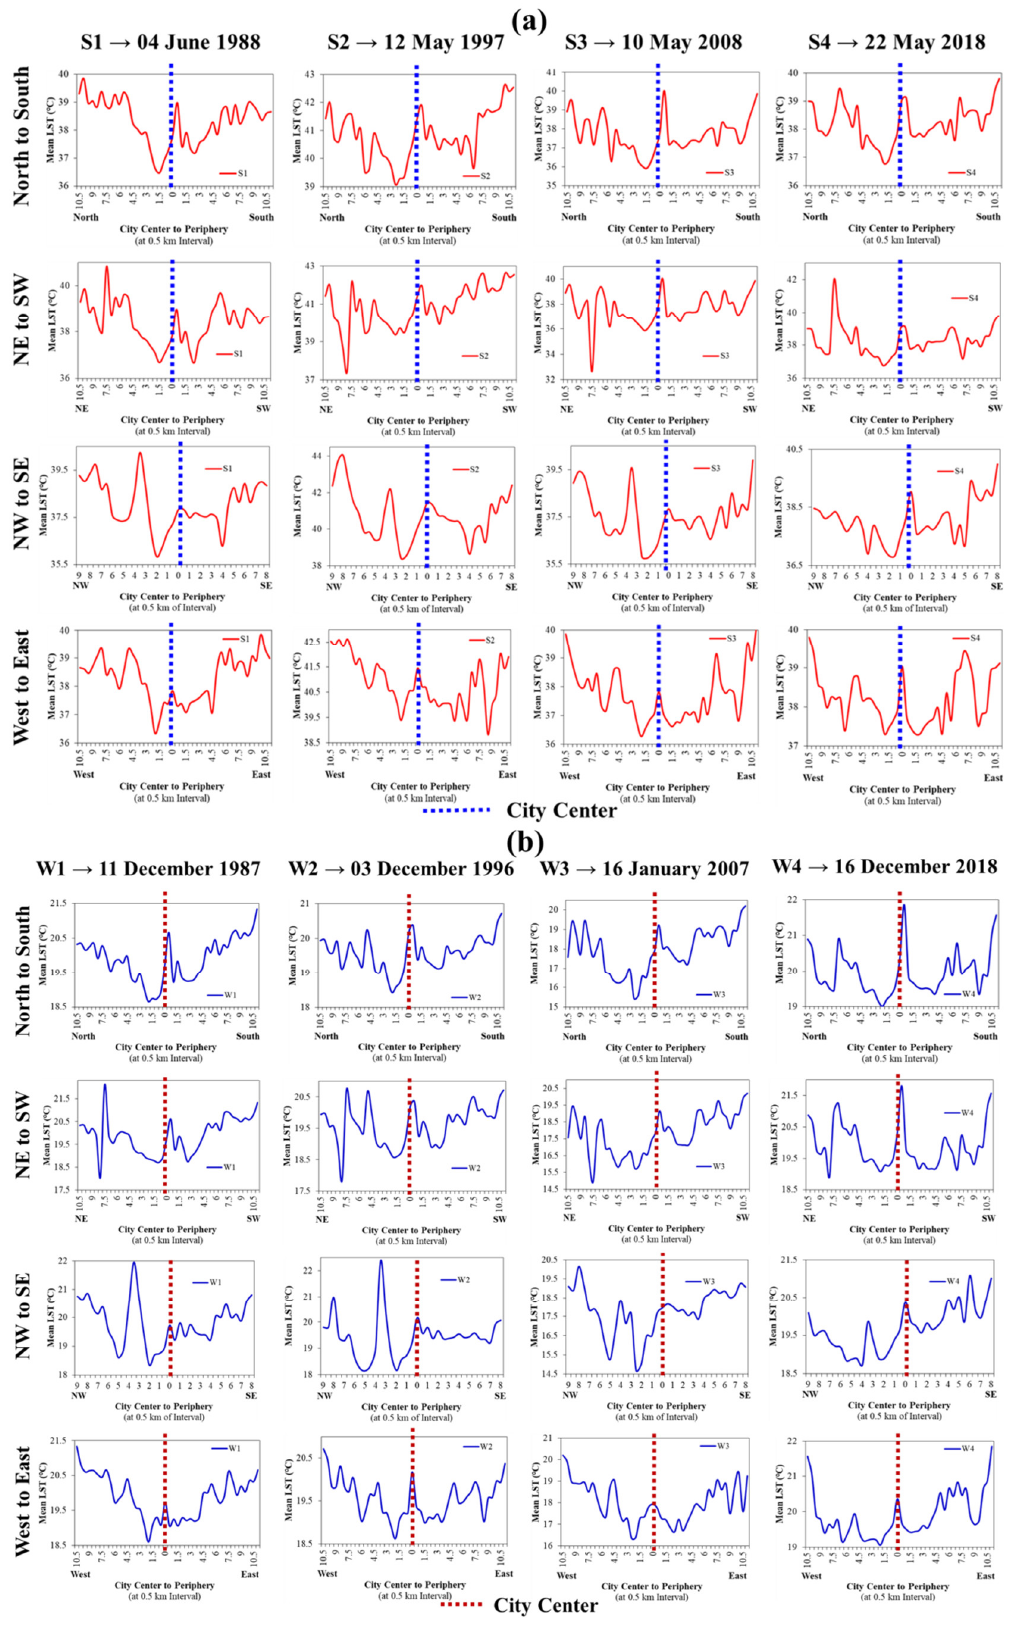
Figure A2. Seasonal LST profiling for SUHI formation in Prayagraj city (1987–2018): ( a ) summer and ( b ) winter.